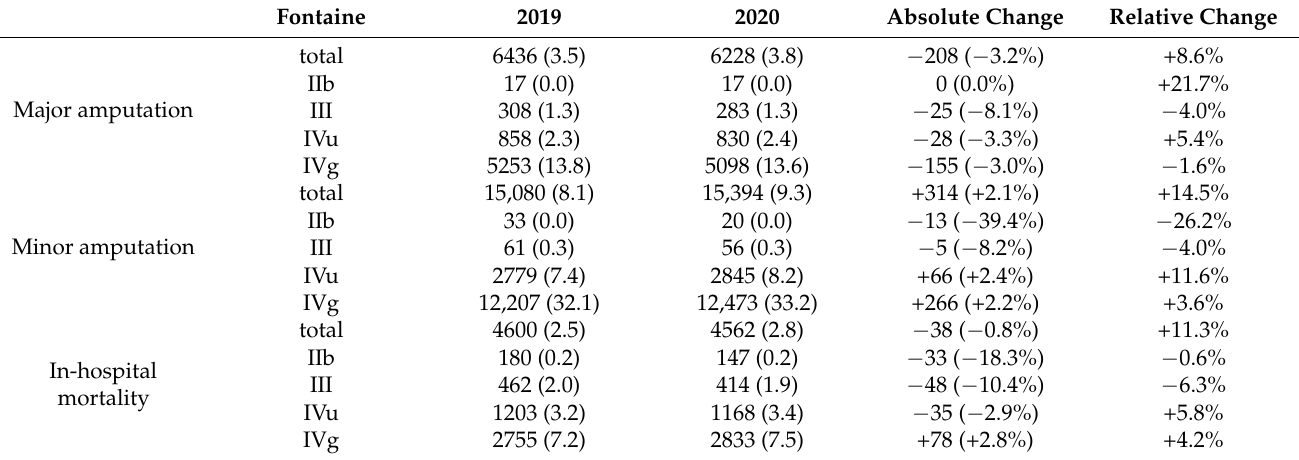
Table 3. In-hospital outcome of patients admitted due to peripheral artery disease in 2019 and 2020.